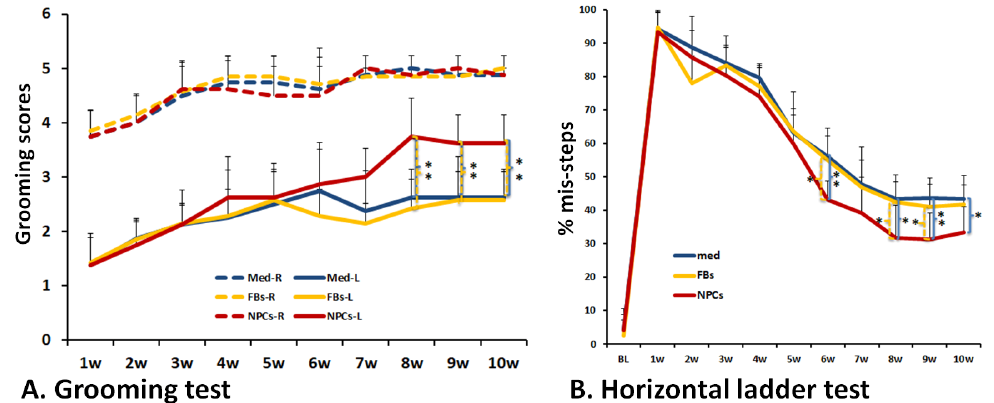
Figure 7. Functional recovery after transplantation of hiPSC-derived NPCs. Human iPSC-derived NPCs were transplanted at 2 weeks after moderate C5 unilateral contusion SCI (IH 150 kdyne) in nude rats. Functional recovery of the forelimb was assessed by the grooming and horizontal ladder tests. Grooming scores ( A ) in the injured side (solid lines) were significantly greater in animals receiving NPC grafts compared to group receiving human fibroblasts or culture medium, respectively, starting 8 weeks after injury (6 weeks after transplantation). The percentages of misstep in the injured forelimb, as measured by the horizontal ladder test, were also significantly lower in the NPC grafting group compared to the other two groups at 6, 8, 9, and 10 weeks after injury ( B ). Data in ( A , B ) represent the man ± SD (n = 8), * in ( B ), p < 0.05; ** in ( A , B ), p <